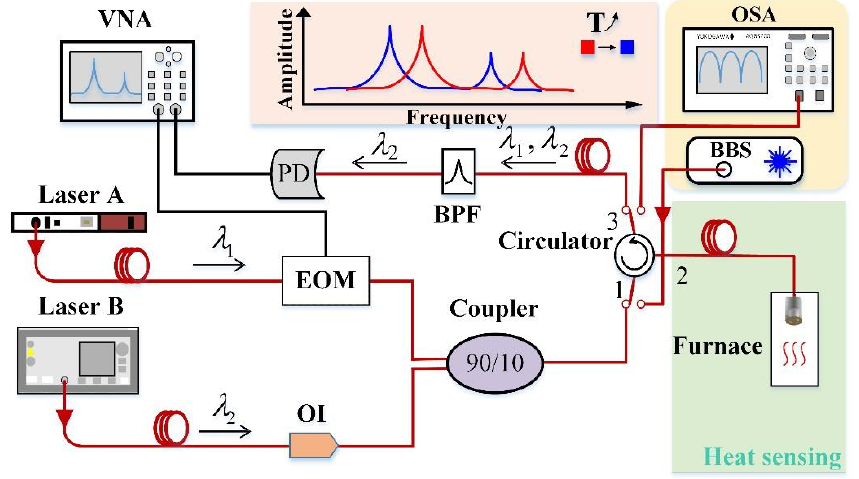
Figure 2. Experimental setup for thermal stress measurement. The all-fiber experimental setup for monitoring the response of a fiber tip resonator to temperature changes and acquiring optical reflection spectra.